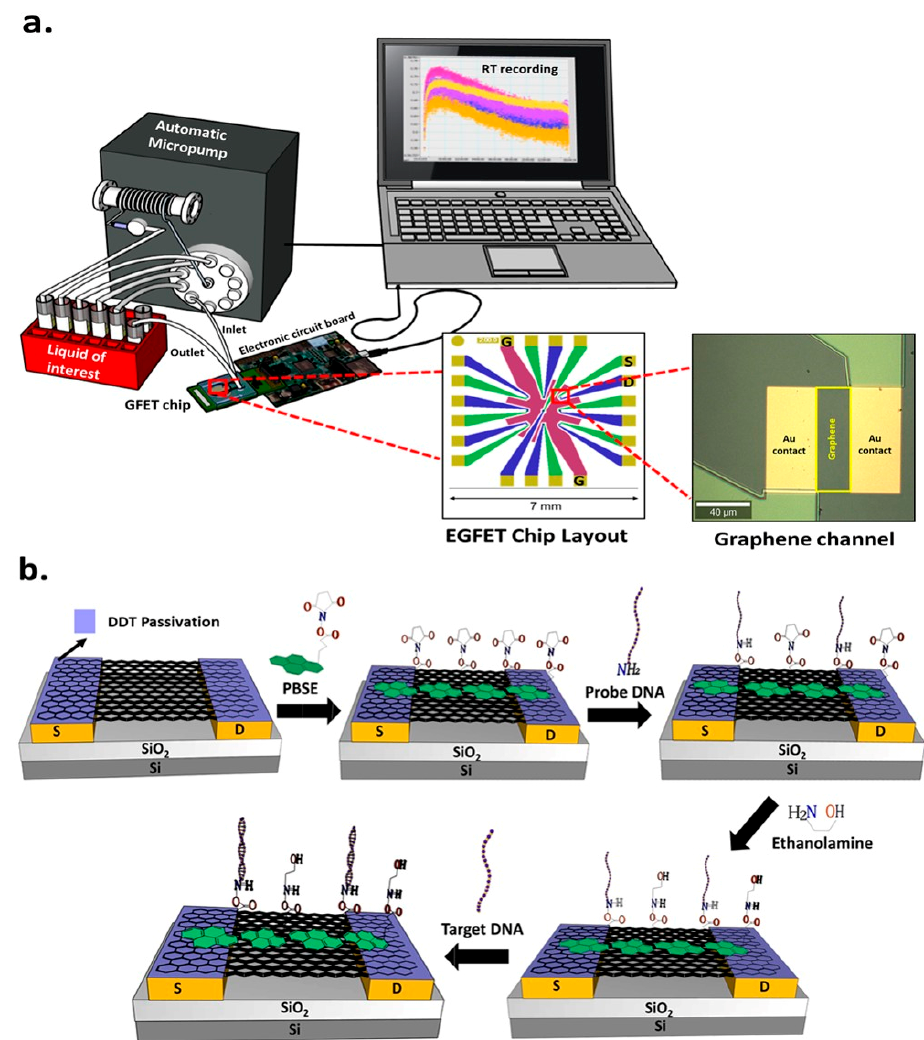
Figure 1. ( a ) The integrated portable system with automatic micropump and electronic reader of the graphene channel on the chip, ( b ) surface functionalization and DNA hybridization strategy.